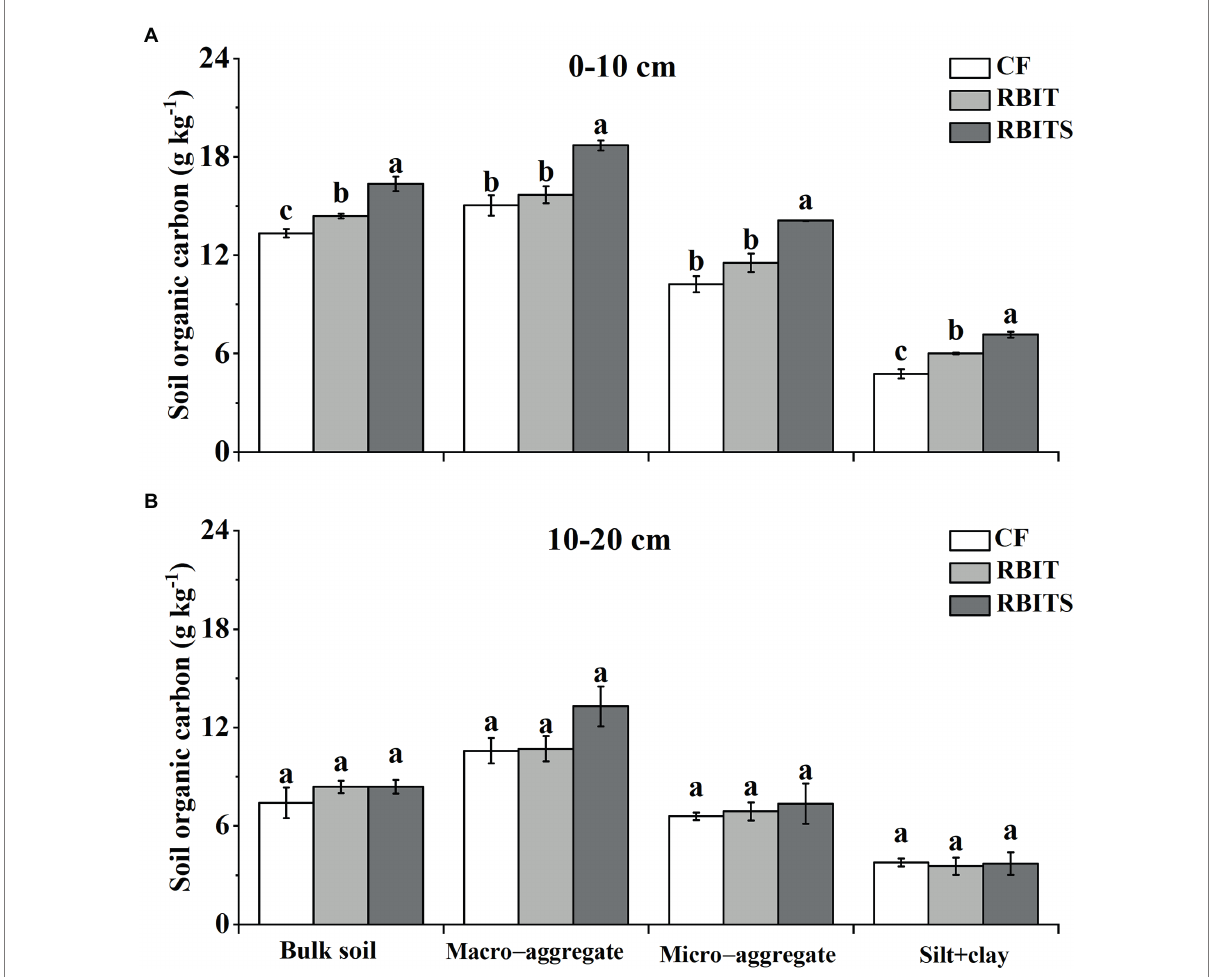
FIGURE 4 Effect of fertilization management on the SOC content in the bulk soil and aggregate fractions at depths of 0–10 cm (A) and 10–20 cm (B) after nine years. CF : conventional fertilization; RBIT: reduced basal and increased topdressing fertilizer rate; RBITS: RBIT combined with straw incorporation. Different lowercase letters represent significant differences ( p ≤ 0.05) among treatments in each graph and for each fraction. Error bars are standard error (SE) of the